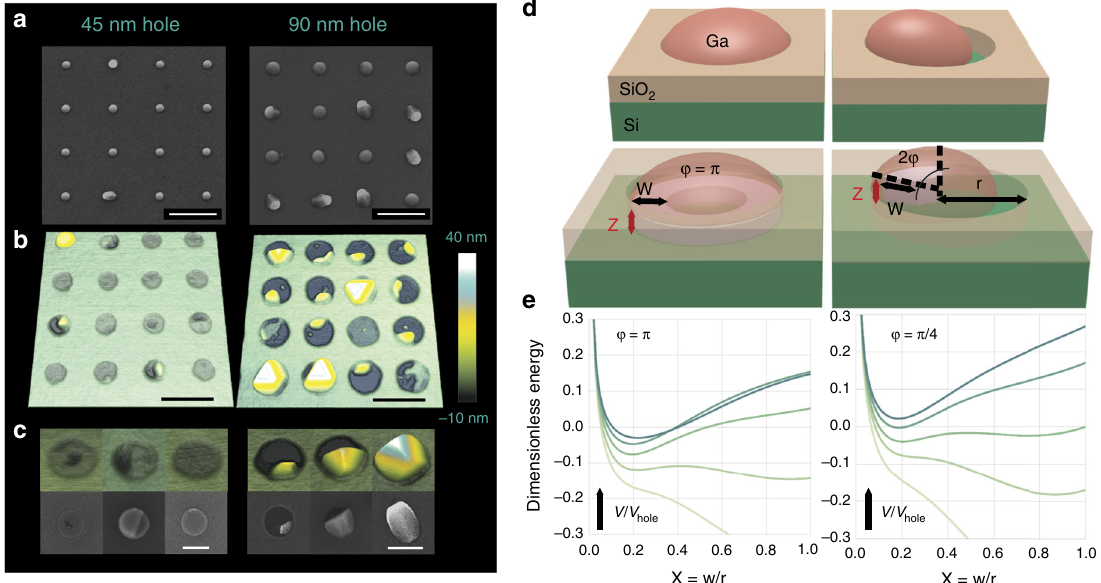
Fig. 3 Seeding the nanowire growth. a SEM images of 400 nm pitch arrays grown for 2 min in 45 and 90 nm holes. Scale bar is 400 nm. b AFM images of GaAs crystals in the holes revealed after the droplet removal. The Images were taken from the same sample as in a , but over 200 nm pitch area. Scale bar is 200 nm. c Closer view of the structures shown in b . Scale bars are 100 nm (left), 200 nm (right). d Two different con fi guration of the droplet within the opening — hole fully fi lled and partially fi lled and bellow illustration of GaAs crystals of height z (in red) forming a step ( φ < π ) or full ring ( φ = π ) underneath the large and small gallium droplets. e Free energy of forming a GaAs crystal for the plausible parameters of the system. Each curve on the plots corresponds to the different values of relative volumes V / V hole that is measured in the units of V hole = 2 π r 3 . The preferred width of the crystal equals r only for small volumes of deposited GaAs (the curve at V / V hole = 0.02). After that, the local minimum of free energy develops and stabilizes at ~0.2 r , corresponding to the formation of 3D ring-like or stepwise structures. The arrows on the plots indicate the increase of value of the relative volume. The values of V / V hole are: 0.015, 0.02, 0,03, 0.05, 0.1 for φ = π and 0.003, 0.004, 0.005, 0.007, 0.01 for φ = π